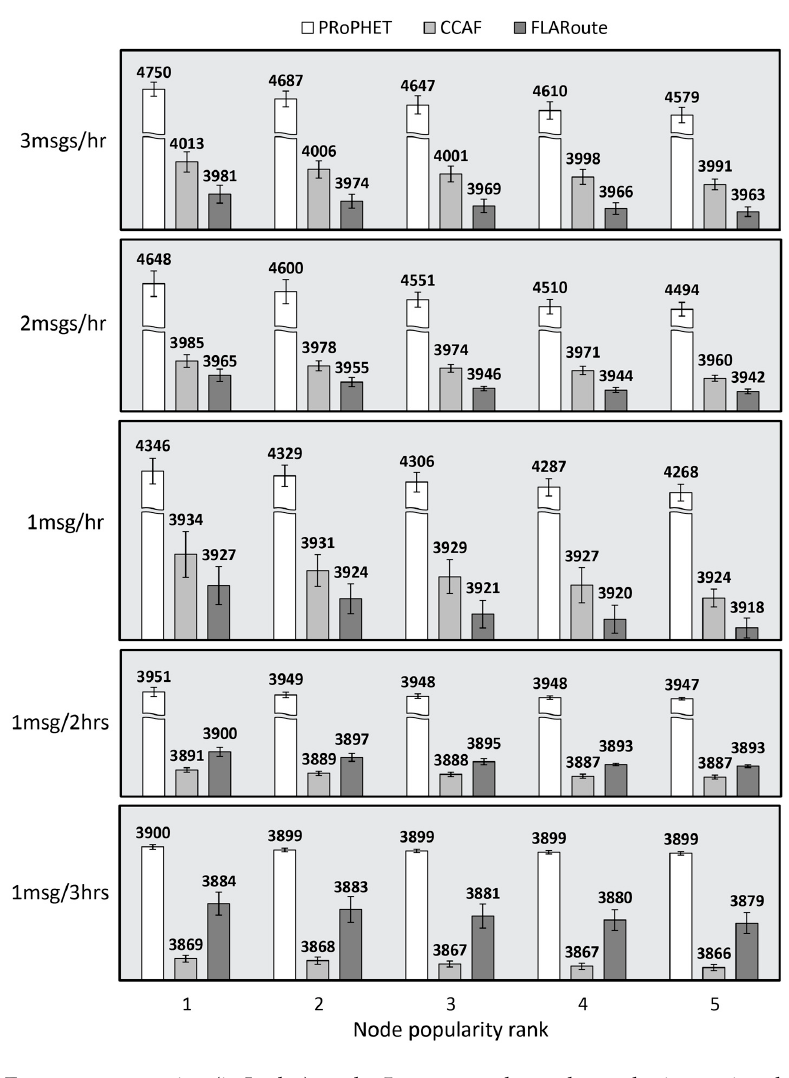
Figure 25. Energy consumption (in Joules) on the 5 most popular nodes under increasing data traffic in the Helsinki scenario.